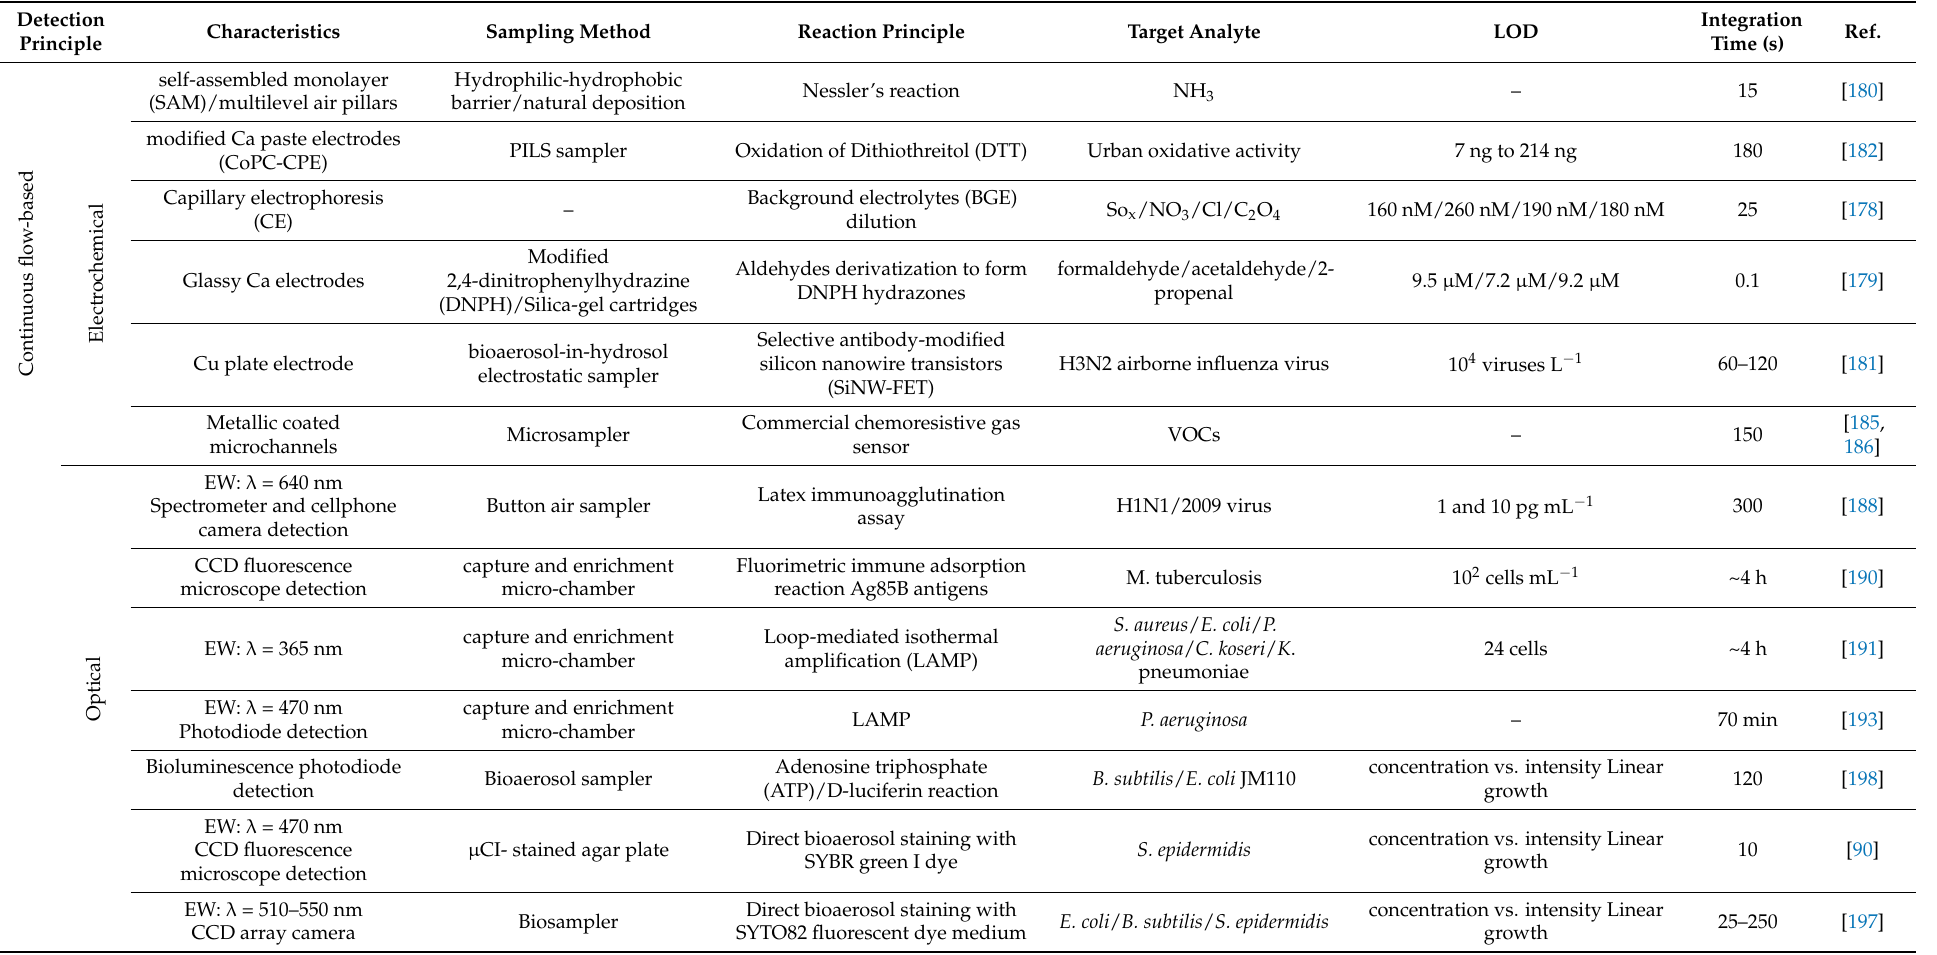
Table A3. Comparison between the key design and performance parameters of the MEMS and NEMS sensors for airborne PM detection found in the